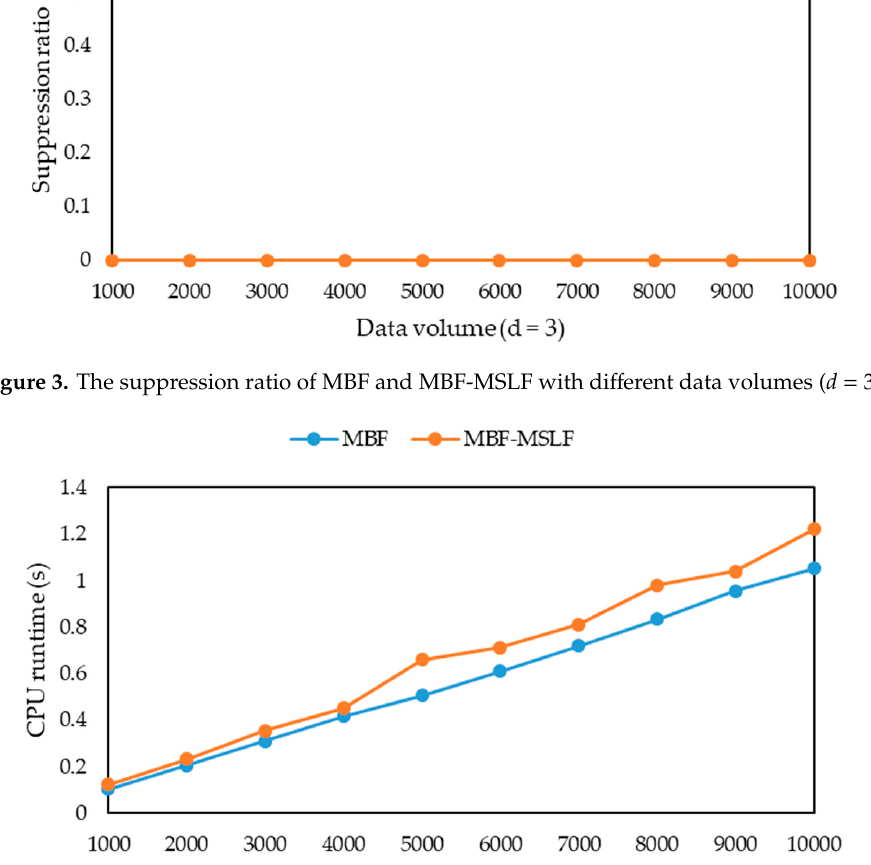
Figure 4. The CPU runtime of MBF and MBF-MSLF with different data volumes ( d = 3).